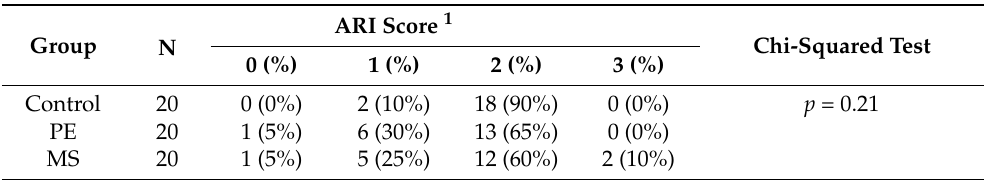
Table 2. The distribution of frequency and percentage and results of the chi-squared test of adhesive remnant index (ARI) scores of each group.